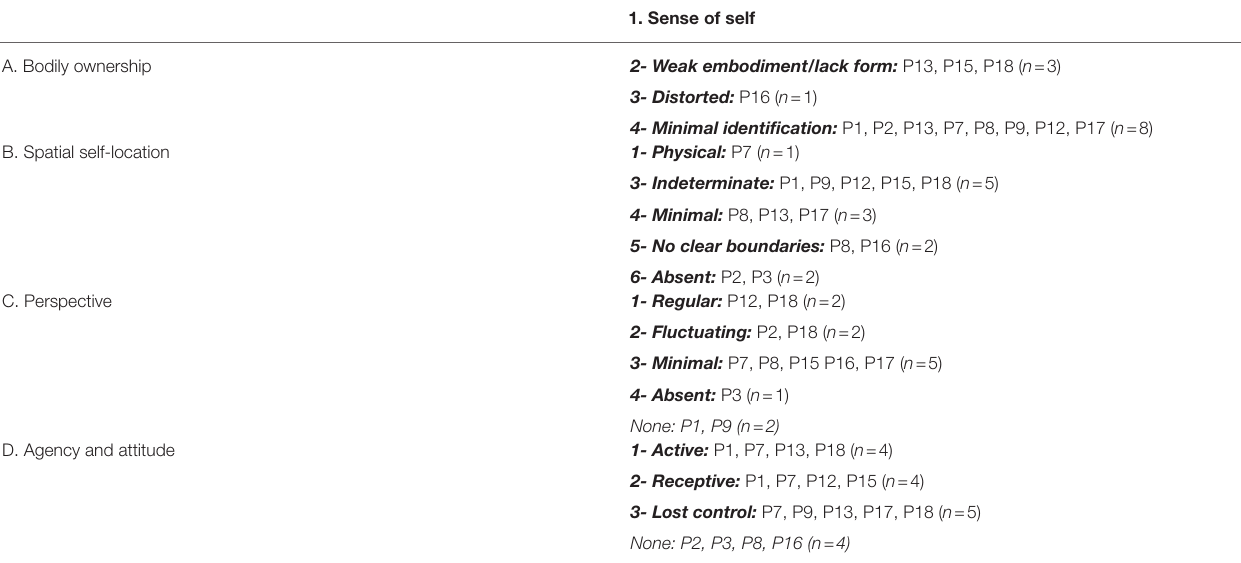
TABLE 1 | Second- and third-level categories and the number of participants mentioning them for the first-level category “ Sense of self